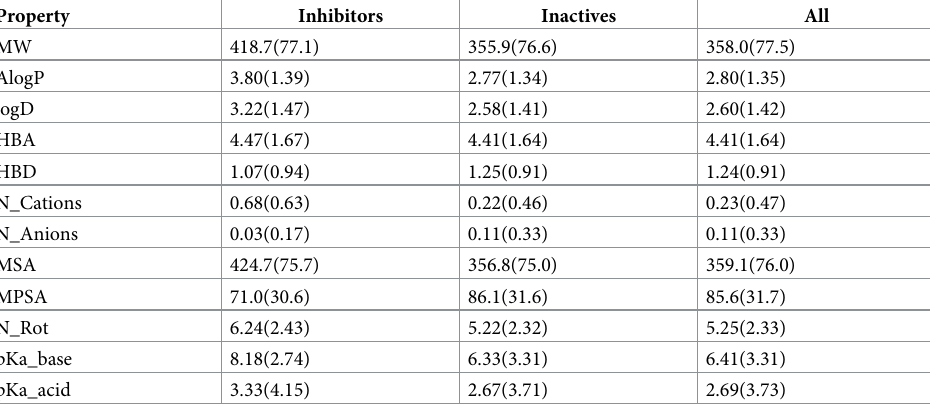
Table 2. Mean values (standard deviations) of 12 physicochemical properties for hERG inhibitors, inactive com- pounds, and all compounds in the integrated database.